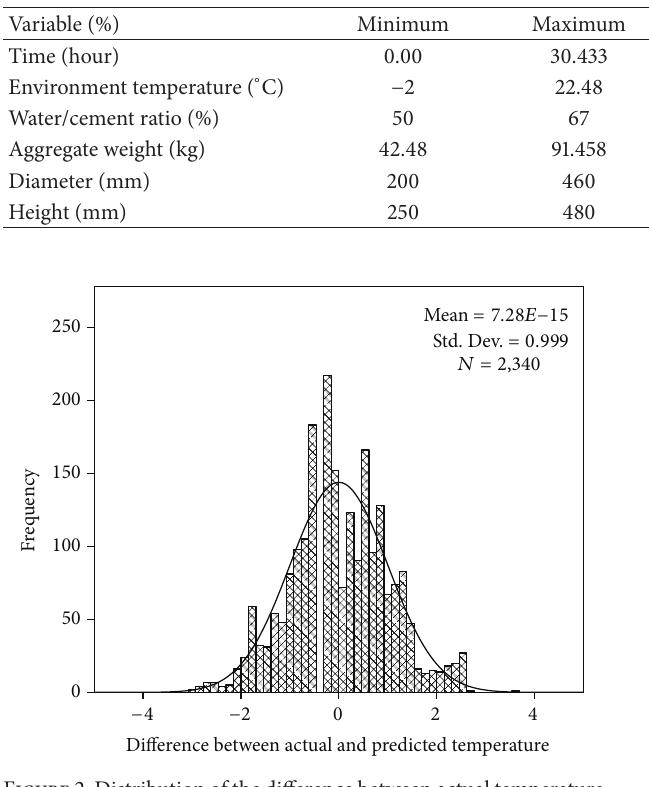
Figure 2: Distribution of the difference between actual temperature values and predicted temperature values obtained from multivariate regression (1).